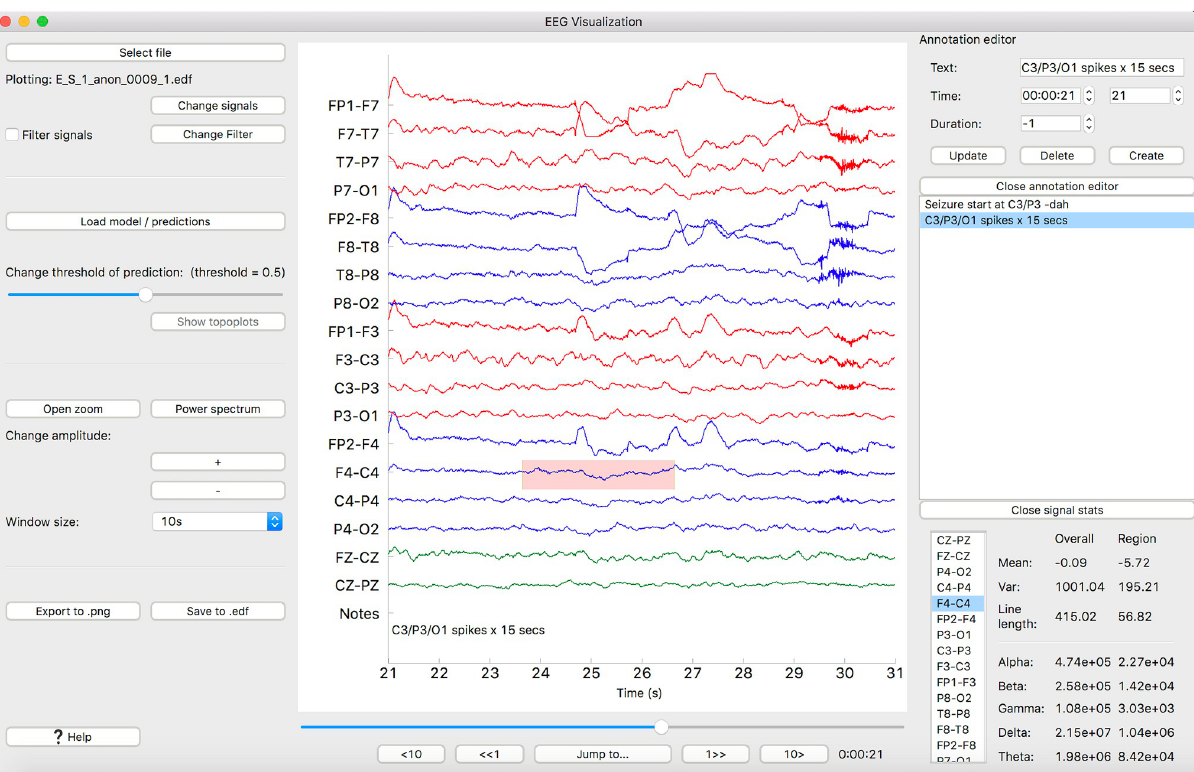
Fig 3. Annotation editor and statistics. The dock on the right side of the plot contains the annotation editor (top) and signal statistics (bottom). The red rectangle on the main plot can be used to select a region over which statistics will be computed.